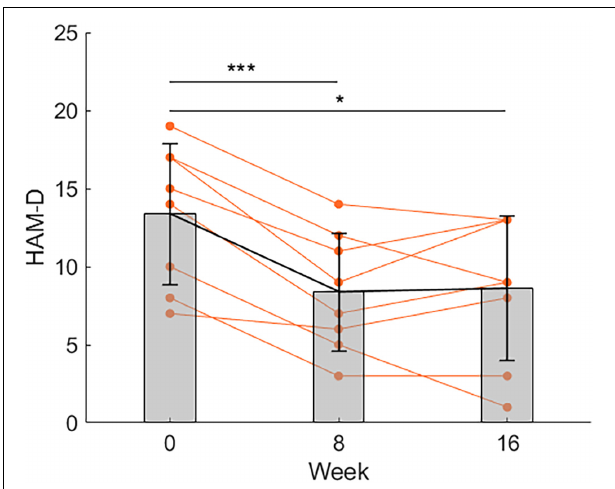
FIGURE 1 | Changes in the score of HAM-D. Compared to before the exercise program (week 0), the mean score of HAM-D significantly decreased at week 8 and maintained at the same level until week 16 ( n = 8). * p < 0.05, *** p < 0.001. Data is shown as mean ± SD. Orange points represent individual data.